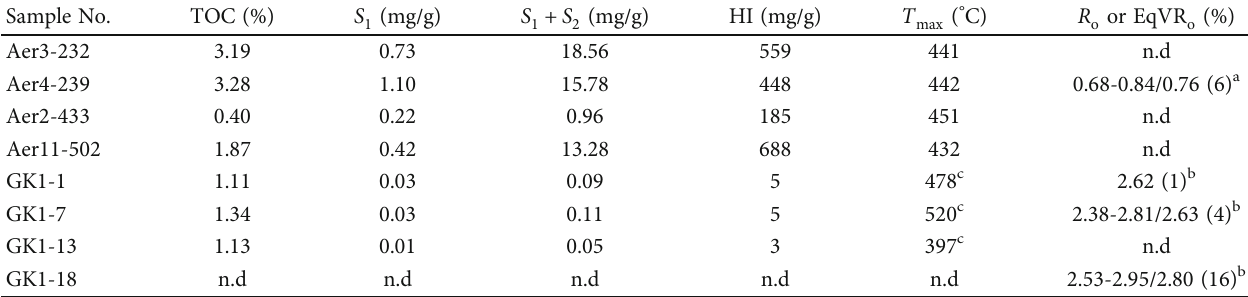
Table 2: Bulk geochemical parameters of studied mudstone samples. Sample No.